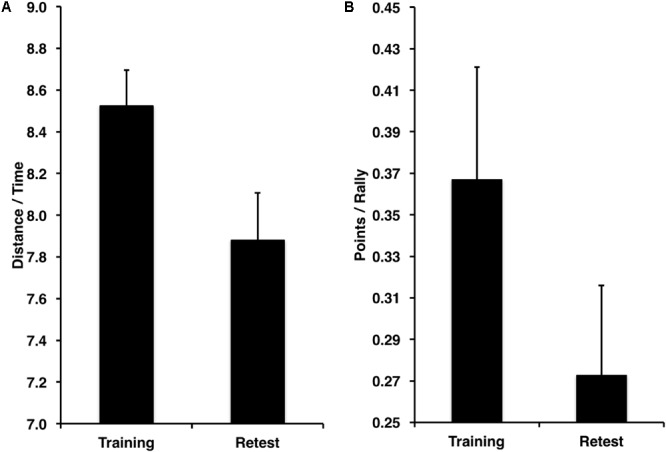
Significant performance improvements from training to retest in terms of speed for the (A) spatial navigation task in distance traveled toward the target (a.u.) per amount of time in seconds, (B) and number of points won per number of rallies played.